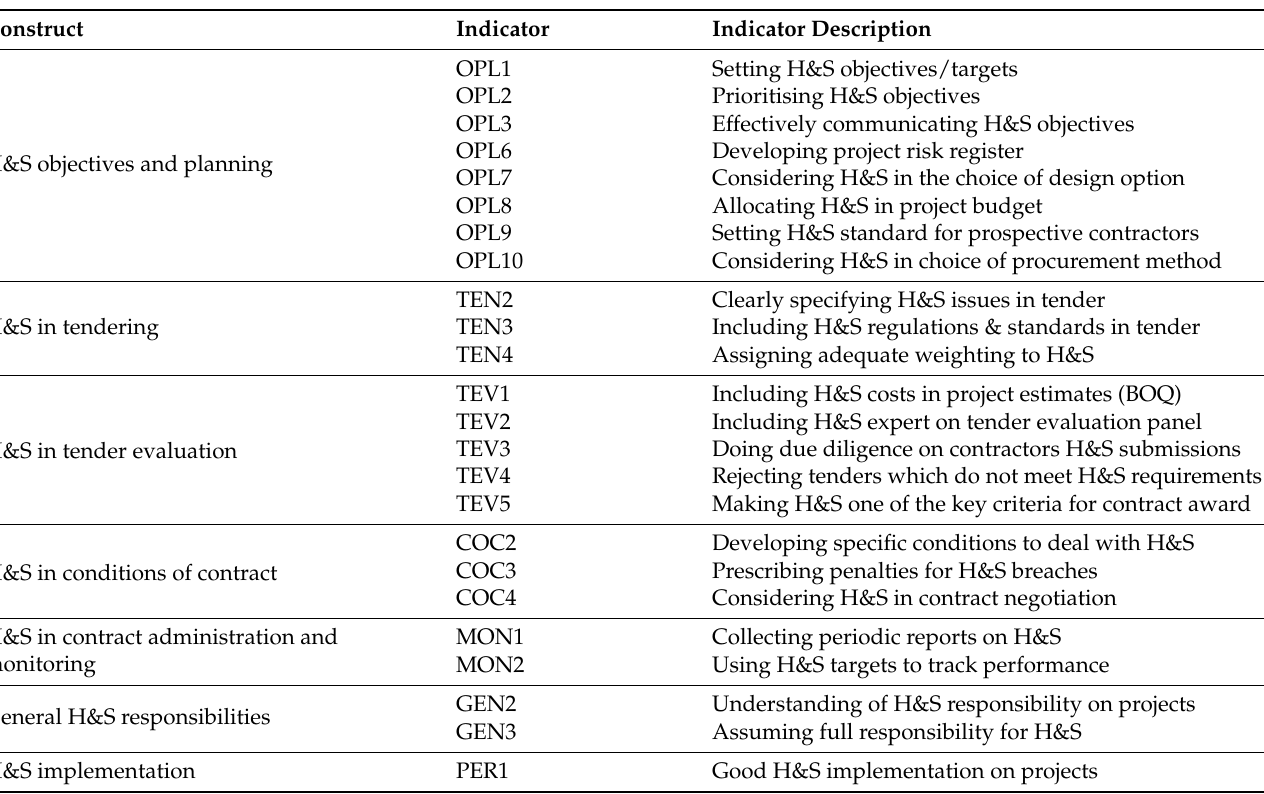
Table 3. Indicators retained and used in path analysis model.